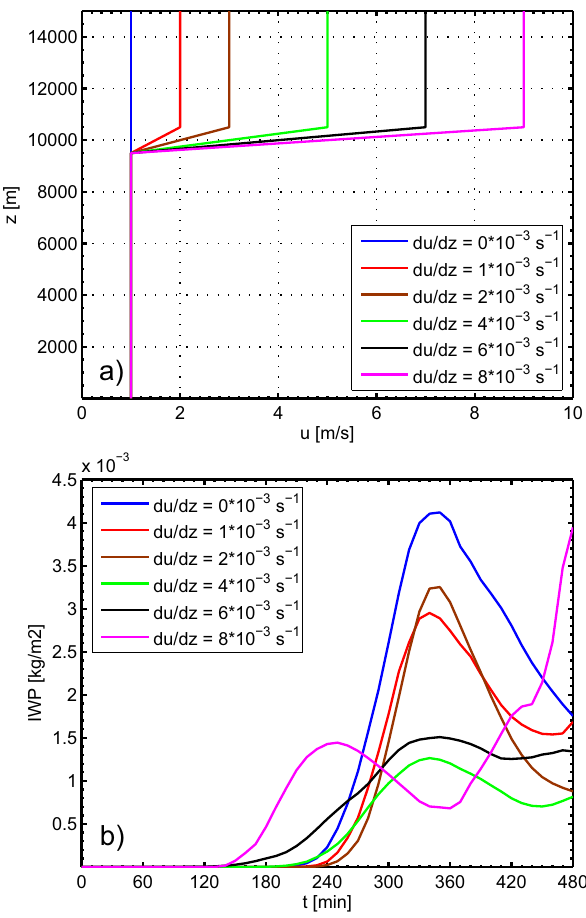
Fig. 8. (a) 6 vertical profiles for horizontal wind speed containing different wind shears within the ISSR. The red line represents the reference case; (b) IWP (averaged over all columns) for windshears from 0 to 8 × 10 − 3 s − 1 .